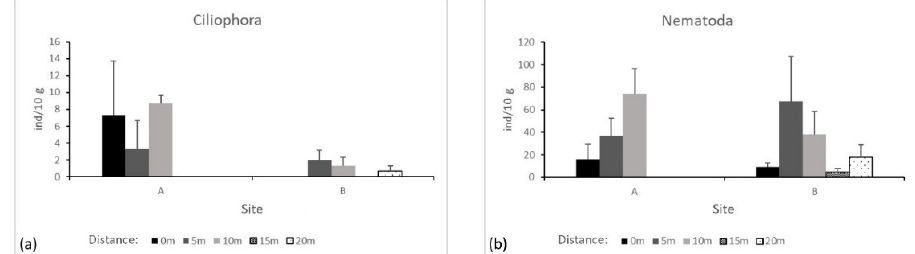
Figure 4. Average and Standard Error of phyla accounting for at least 90% of total microfauna abundance. ( a ) Ciliophora and ( b ) Nematoda abundance per 10 g of soil. No letters above bars mean no significant differences within transects ( p > 0.05).